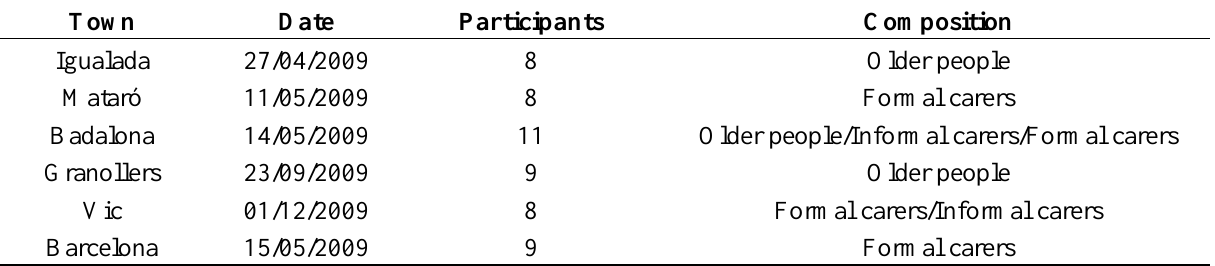
Table 1. Composition of the focus